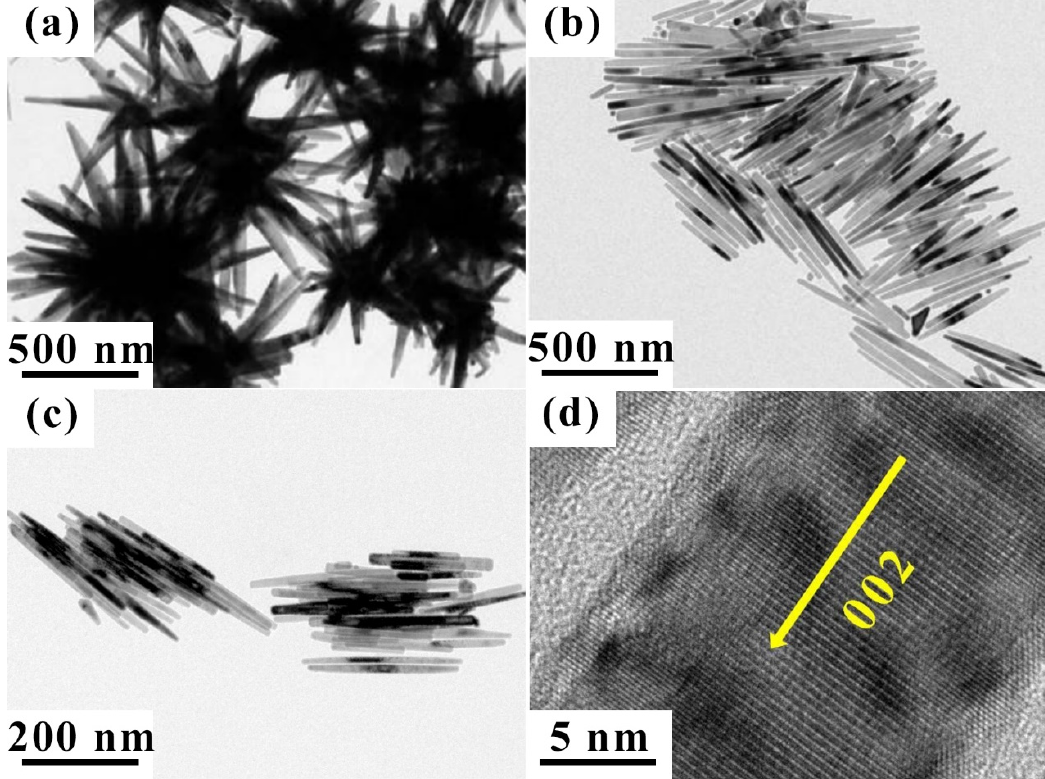
Figure 2. TEM images of Co nanoclusters with different n Ru /n Co molar ratios of ( a ) 0.0, ( b ) 0.2%, and ( c ) 0.4%, and ( d ) a high-resolution TEM image of a single Co nanorod.